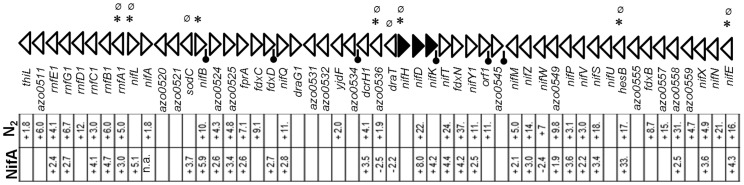
Schematic representation of the core nif gene cluster (azo0510- azo0562) and its expression in Azoarcus sp. strain BH72.The nif structural genes nifH, nifD and nifK are represented by solid triangles. Black bars with round caps when denoted in the intergenic region represent transcription termination loops. The symbols ∗ or Ø on top of a triangle denotes the occurrence of predicted RpoN-binding site or NifA binding site upstream of that particular target gene, respectively. Upper row (N2) represents fold change of expression of genes of the nif cluster from triplicate microarray experiments either up-regulated (+) or down-regulated (−) under N2 fixation. Lower row (NifA) represents fold change of expression of the genes of the nif cluster either positively (+) or negatively (−) regulated by NifA. Empty rectangles below a gene represent no significant modulation of expression of that gene of interest under one or both of the microarray experiments. N. a., not applicable in case of nifA mutant.